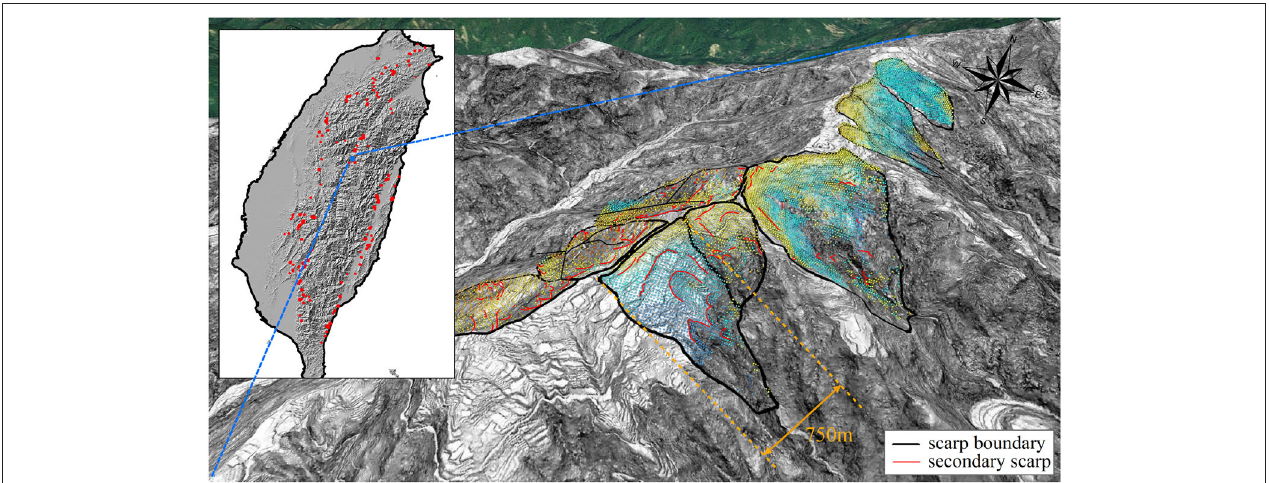
FIGURE 1 | The distribution of the 186 identified potential deep-seated landslide sites in Taiwan (inset panel, Soil Water Conserv.Bureau, 2018), and 10 examples of the scarp boundaries of the potential deep-seated landslides in Ren’-ai Township, Nantou County ( Central Geological Survey, 2010). The dots in the scarp areas represent the line-of-sight deformation obtained by using the temporarily coherent point interferometry SAR (TCPInSAR) technique ( Chen et al., 2017). Note that the length scale varies according to the 3D